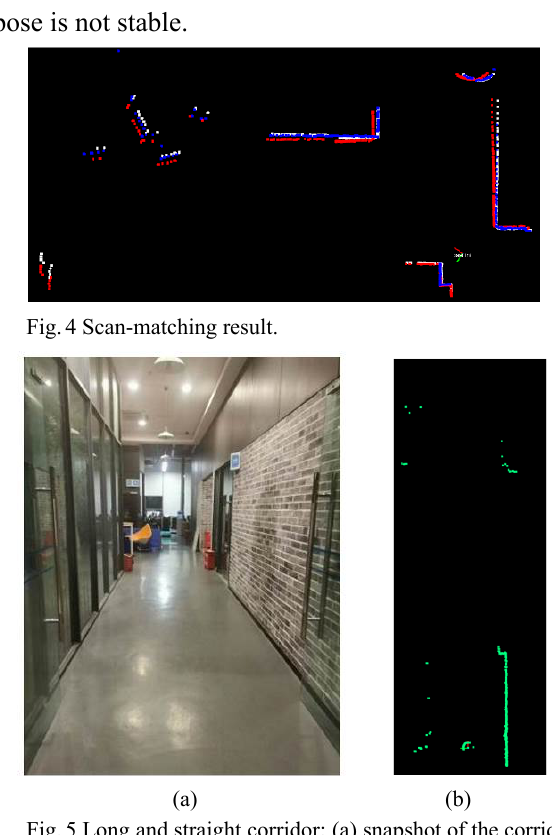
Fig. 5 Long and straight corridor: (a) snapshot of the corridor and (b) correspond lidar points.